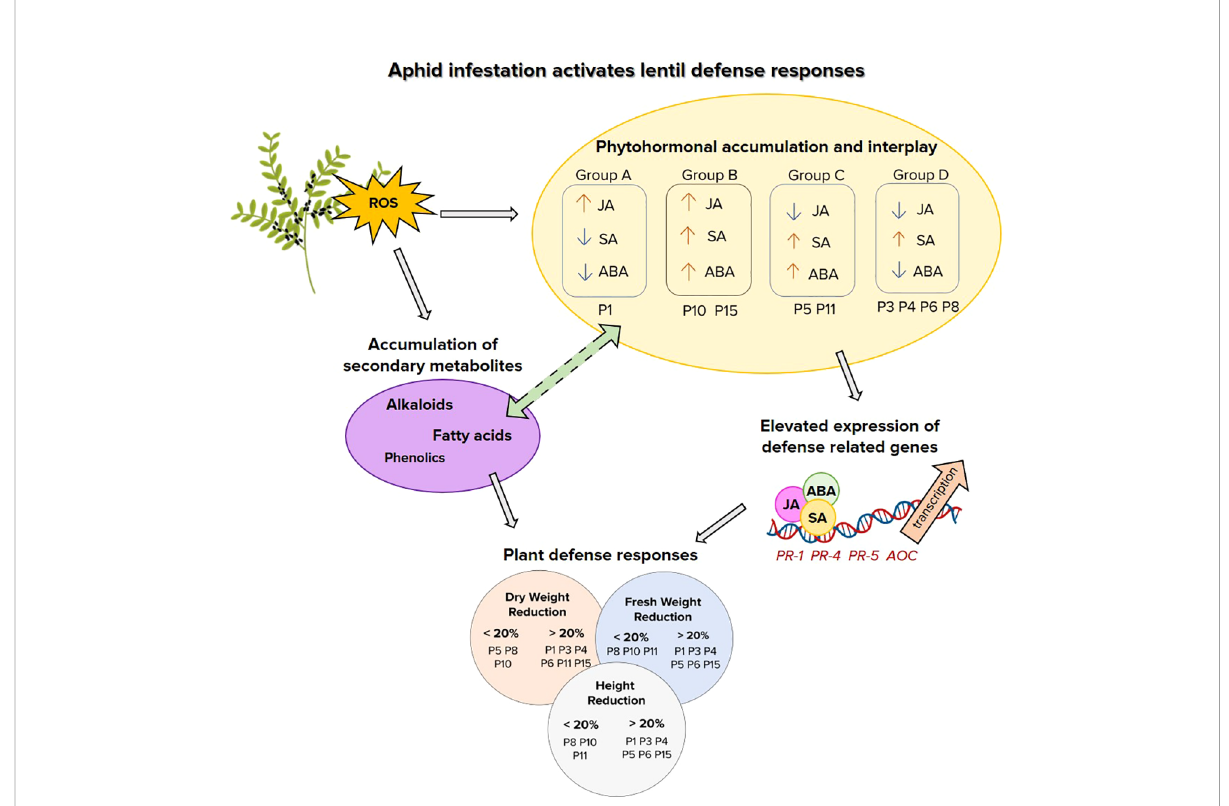
FIGURE 7 Schematic representation of lentil-aphid interactions and defense signaling pathways. Reactive oxygen species (ROS), jasmonic acid (JA), salicylic acid (SA), abscisic acid (ABA). Pathogenesis related genes PR-1, PR-4, PR-5 and allene oxidase cyclase (AOC).